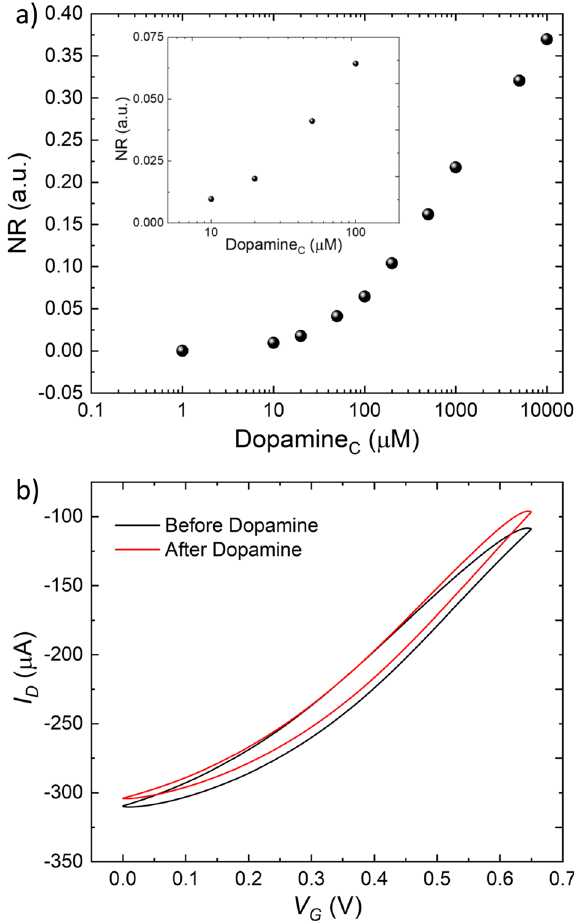
Fig. 5 Dopamine sensing. a Dose curve for dopamine detection (zoom-in of the 10 – 100 µM region is shown in the inset). b Transfer curves before and after dopamine